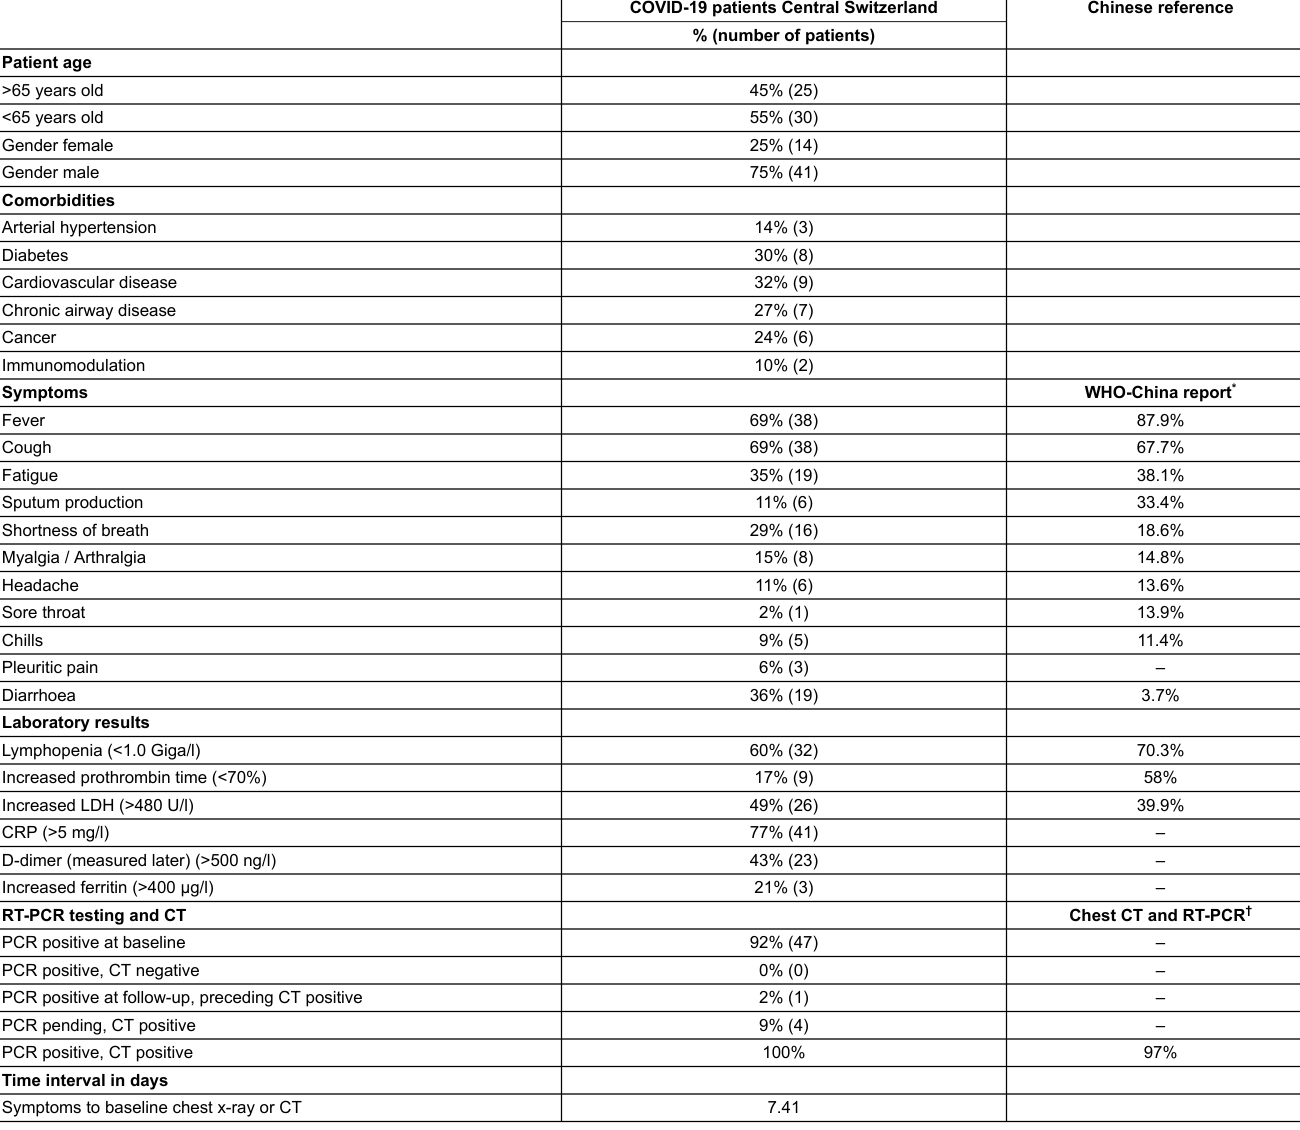
Table 1: Demographic data, symptoms and laboratory test data of our patient cohort in Central Switzerland (n = 55)